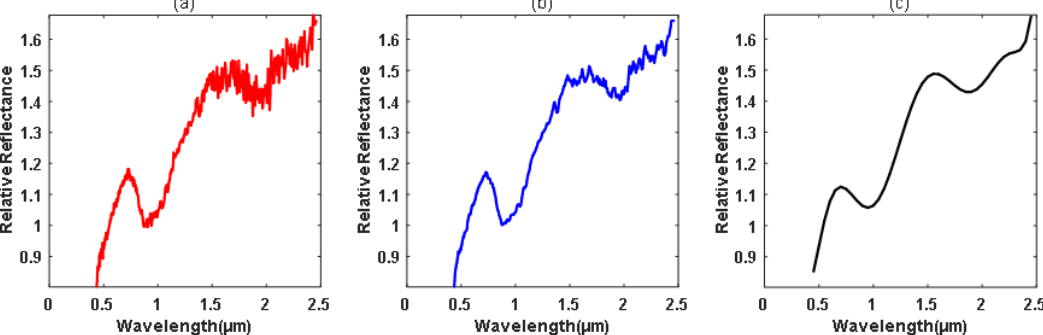
Figure 5. The spectral preprocessing for (1807) Slovakia with category ‘S’. ( a ) Original spectra; ( b ) smoothed spectra; ( c ) fitted spectra spanning the wavelength range 0.45 to 2.45 µ